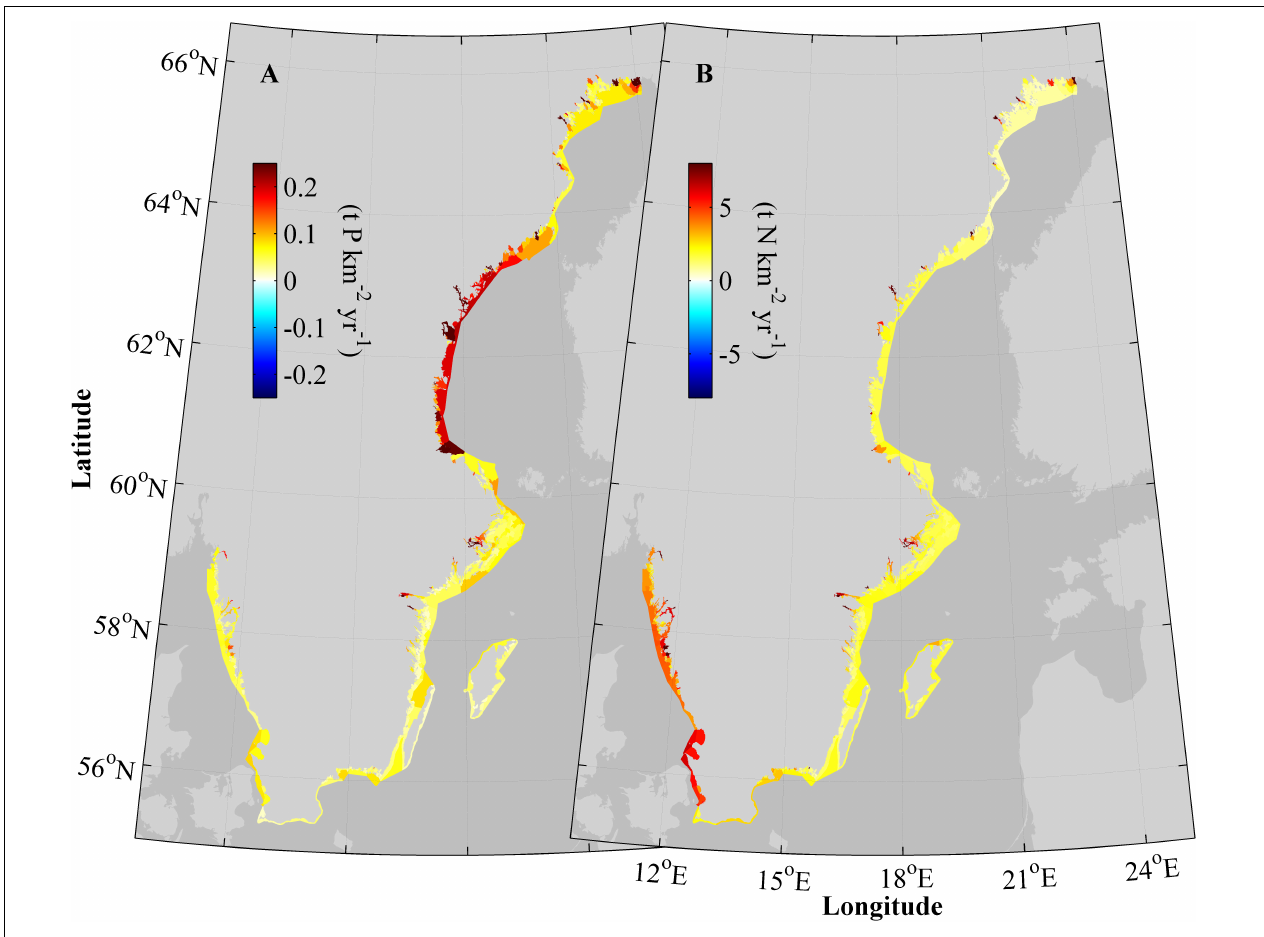
FIGURE 6 | A 20 years average (1995–2014) of total retention, R tot , of phosphorous (A) and nitrogen (B) normalized to area and in all modeled water bodies.